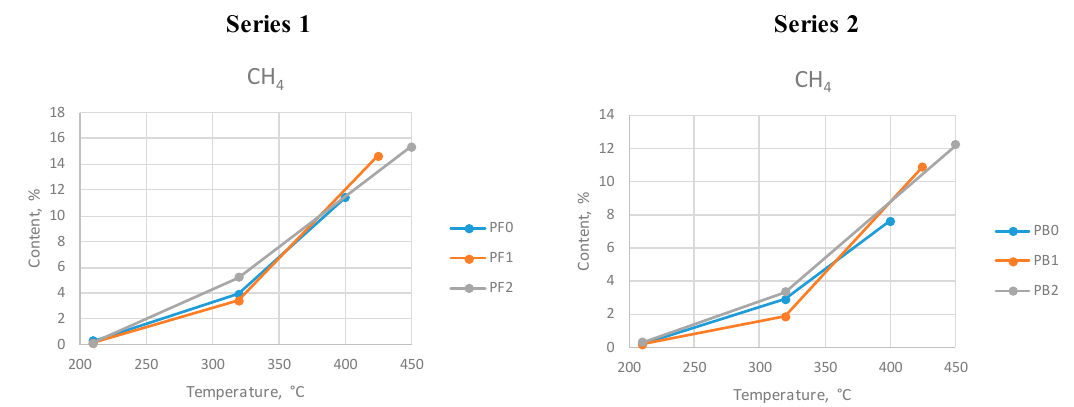
Figure 4. Methane content at di ff erent max. temperatures during series 1 and 2.